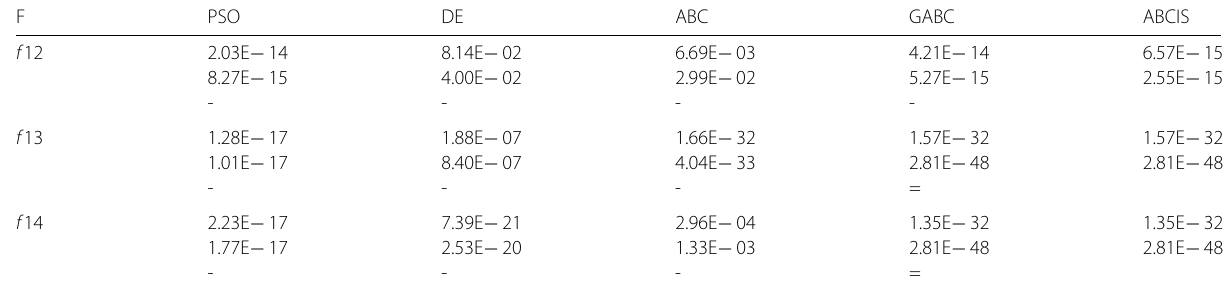
Table 3 Comparison results, D = 30 ( Continued )